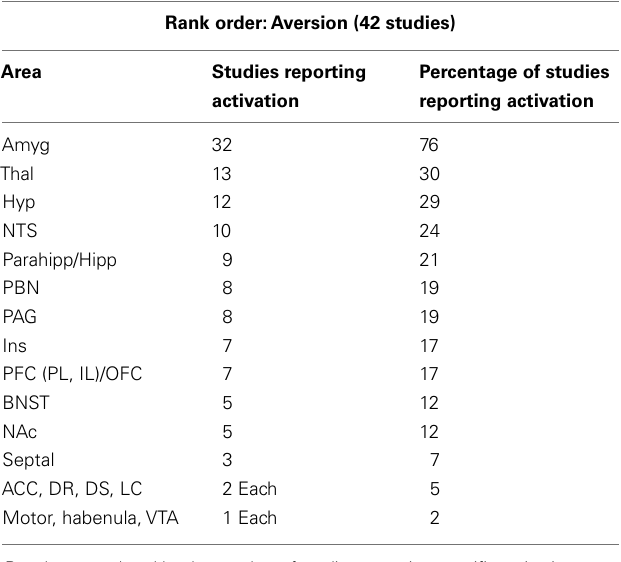
Table 2 |Aversion network in humans – clusters. Table 3 | Major brain activations in 42 aversion non-human animal